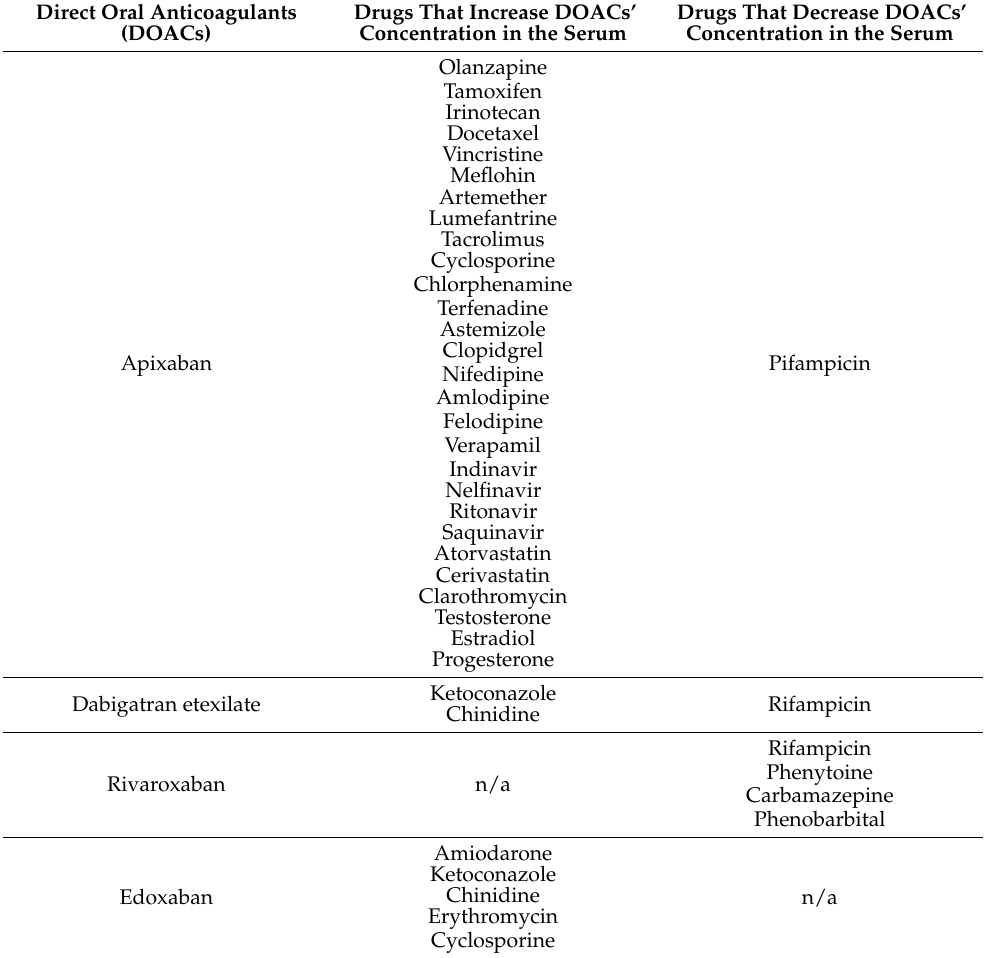
Table 1. Drug–drug interaction of the DOACs. Direct Oral Anticoagulants